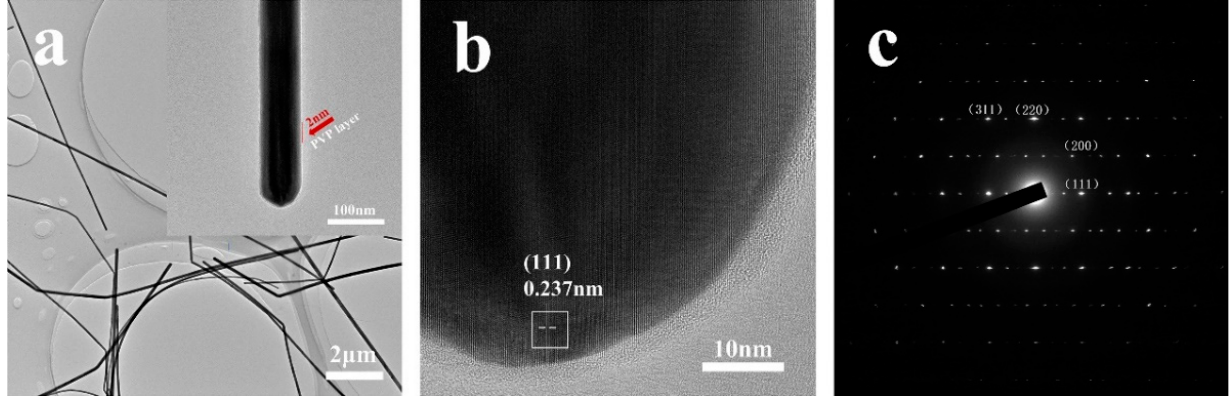
Figure 3. ( a ) Low-resolution TEM, ( b ) high-resolution TEM, and ( c ) SAED images of Ag NWs with an average diameter of 60 nm.